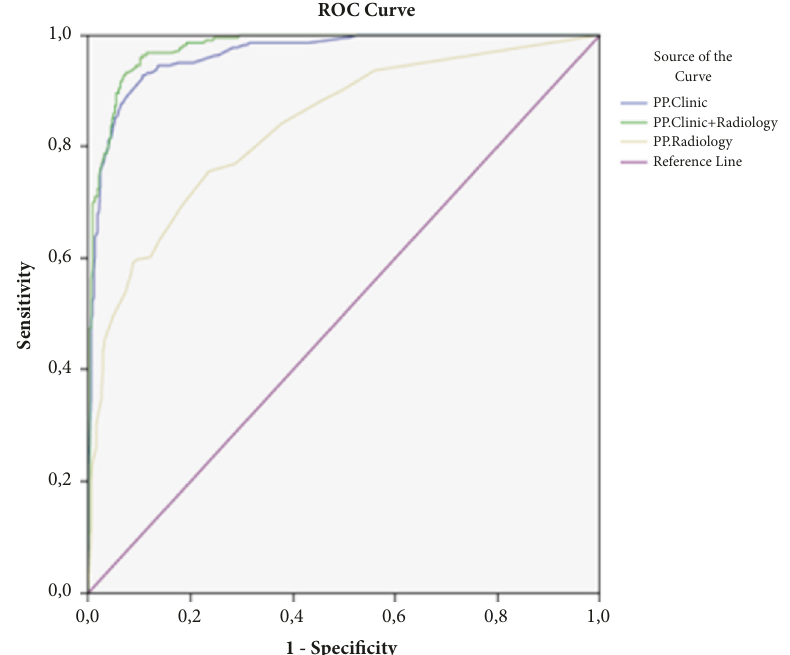
Figure 2: ROC curves of evaluation without radiological predictors (AUC=0.966, CI=0.953-0.979, and p ≤ 0.001), with only radiological predictors (AUC=0.836, CI=0.802-0.870, and p ≤ 0.001) and with clinical, biochemical, and radiological predictors (AUC=0.978, CI=0.969- 0.987, and p ≤